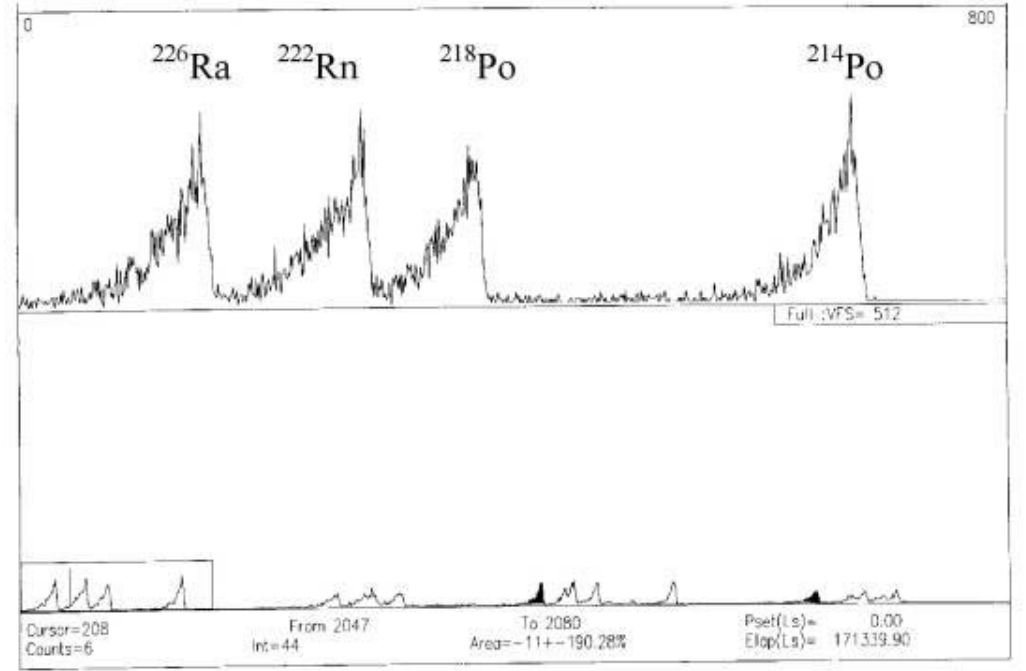
FIGURE 2A . Alpha ray spectrum for a sample IAEA-306 (Baltic sediment) measured right after source preparation.